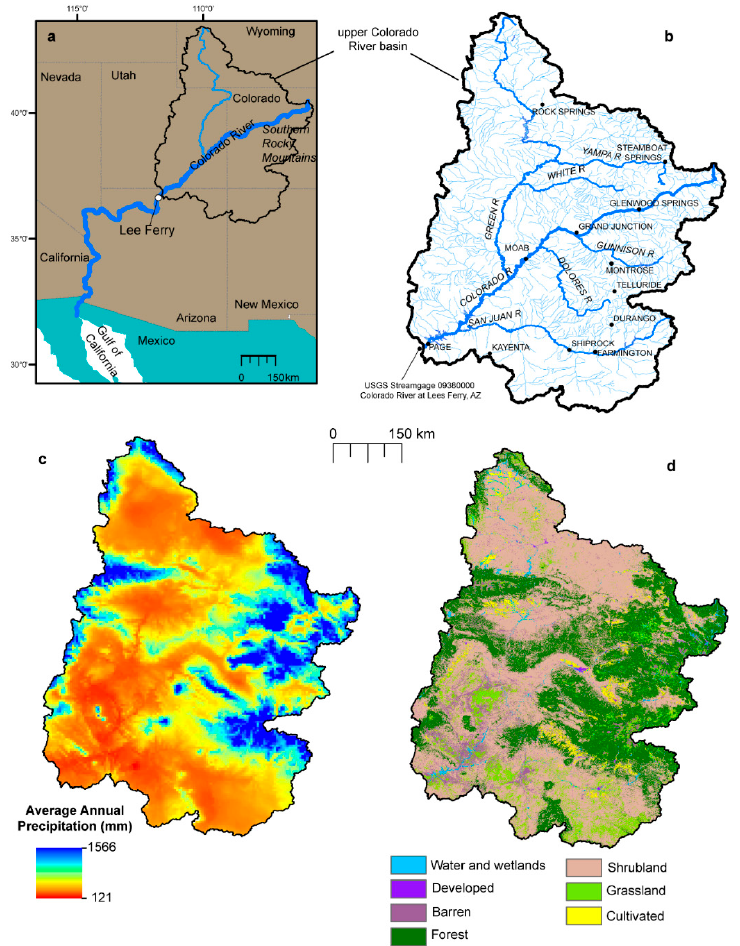
Figure 1. Study area information for the upper Colorado River basin (UCRB): ( a ) Location of the UCRB within the southwestern United States: ( b ) Major tributaries to the Colorado River in the UCRB; ( c ) Average annual precipitation [36], ( d ) Major land-cover classifications [37].